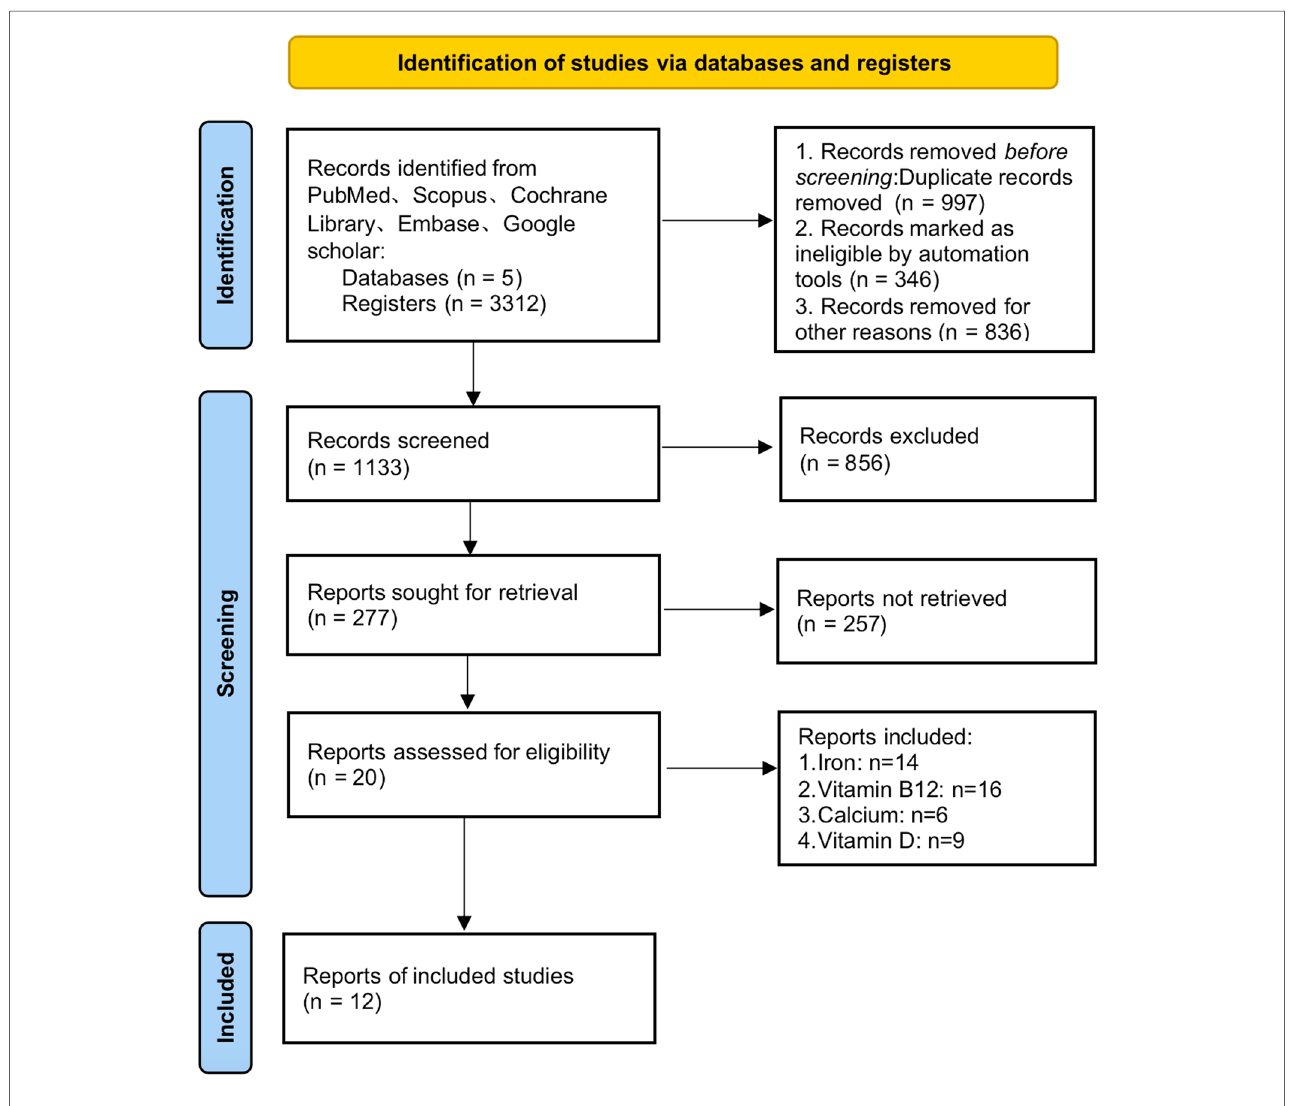
FIGURE 1 PRISMA fl